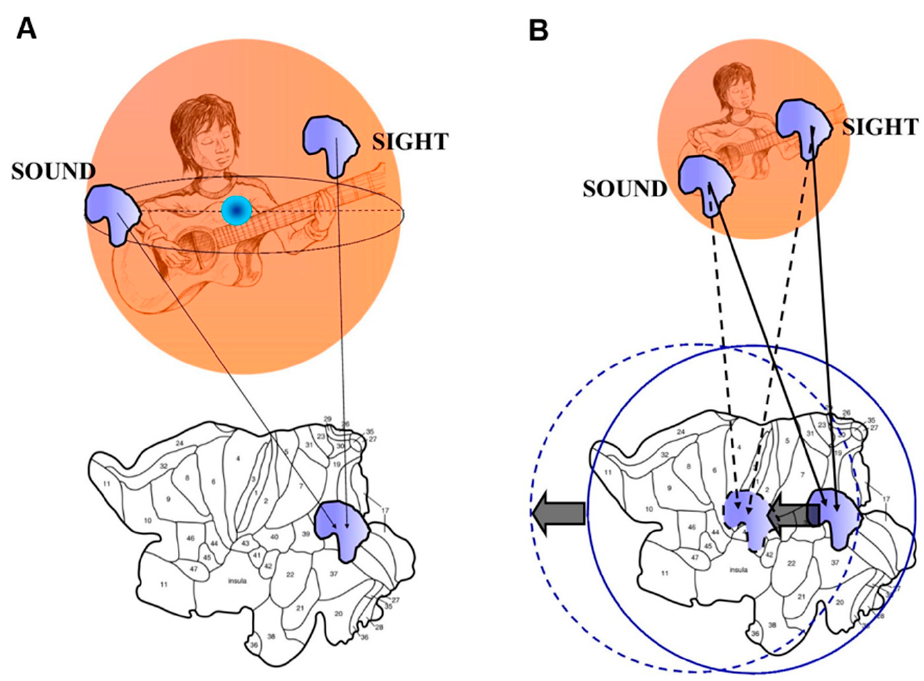
Figure 2. ( A ) A simplified sketch of the reBUT (a variant of the Borsuk-Ulam theorem). The functions with matching description do not need necessarily to be antipodal. Thus, the two inputs from different sensory modalities may arise from every point of the environment, if they are just equipped with a signal matching. ( B ) When the two inputs from different modalities do not match on the 2-D brain surface, a discrepancy occurs between two brain spheres, which can be quantified by evaluating the distance between their two centres. Modified from Tozzi and Peters [37].